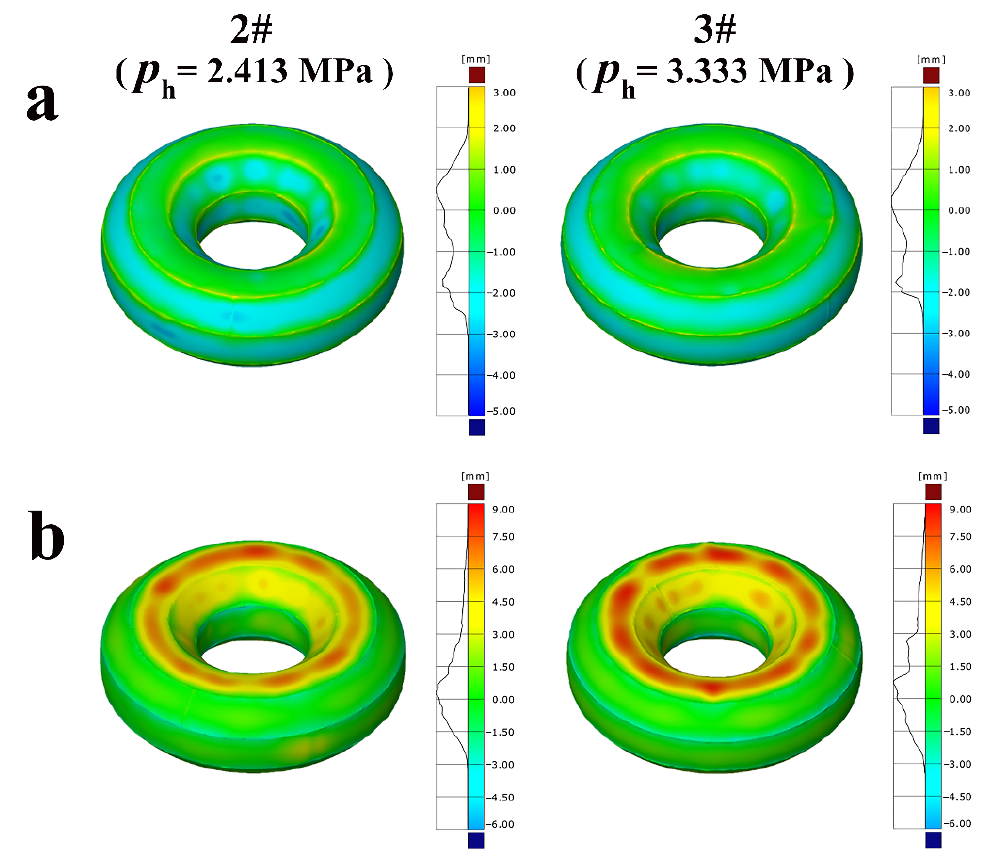
Figure 14. Geometrical deviations of hydroformed toroids from nominal geometry of red lines in Figure 1 ( a ) and from preformed geometries in Figure 13 ( b ).